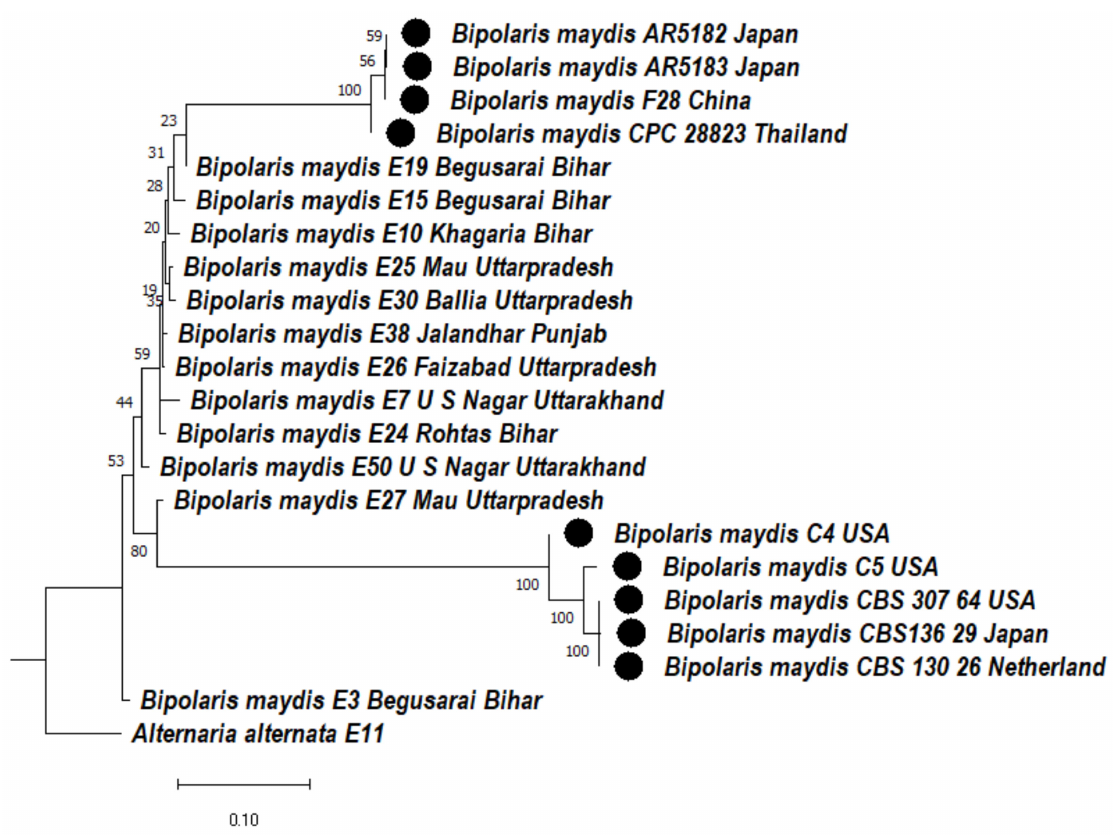
Figure 2. Dendrogram constructed from maximum likelihood method based on combined internal transcribed spacer (ITS) and glyceraldehyde-3-phosphate dehydrogenase (GAPDH). Sequenced data of the Bipolaris maydis isolates were inferred with Raxml based on GTR + Gamma model. Numerical value presented in the node indicates bootstrap value with a 1000 non-parametric bootstrap replicate analysis. The symbol • denotes as ‘ ex-type ’ closely related species sequences obtained from